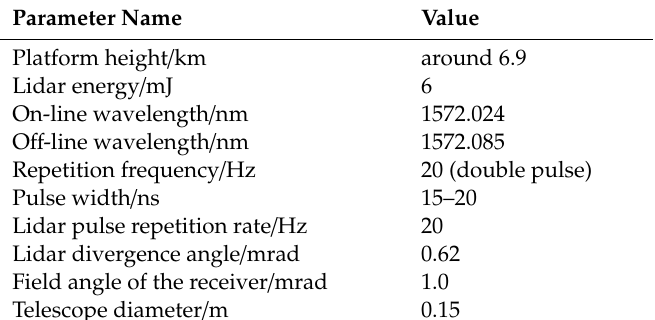
Figure 4. Superimposed on-line and off-line raw signal data. ( a ) Signal waveform shape of the specified proportion saved during the Lidar pulse emission. ( b ) On-line and off-line sea level echo signals.